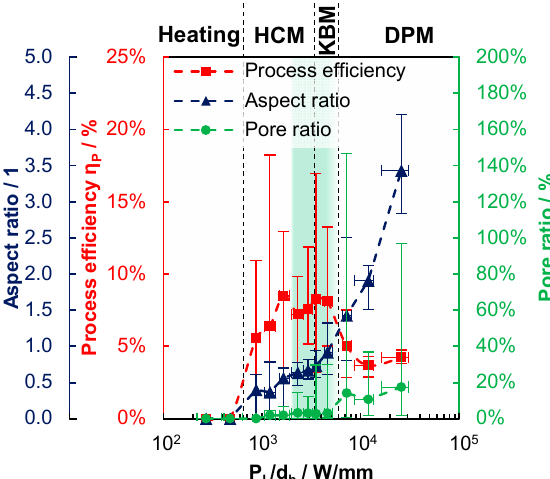
Figure 9. Process efficiency (left, red), aspect ratio (left, blue) and pore ratio (right, green) as functions of P L / d b . Green-colored area: process window for highly efficient laser-based powder bed fusion of AlSi10Mg with reduced pore formation.